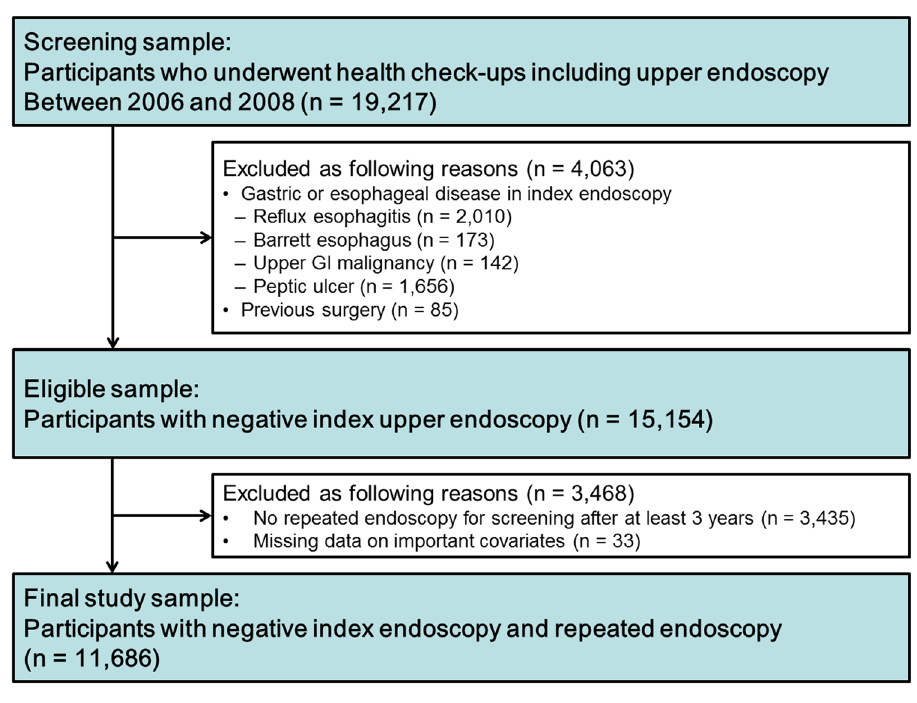
Figure 3. Flow diagram of study